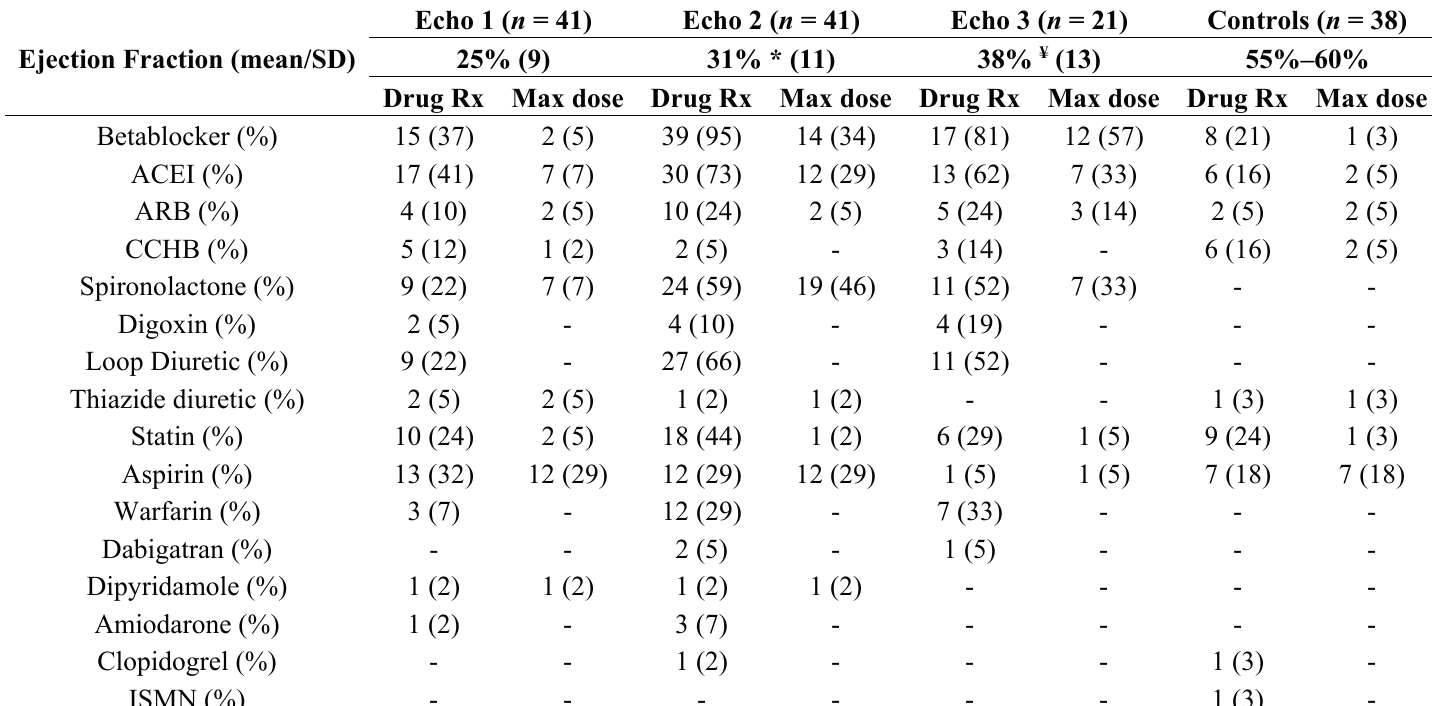
Table 2. Patient medication and left ventricular (LV) ejection fraction at each echocardiogram date.